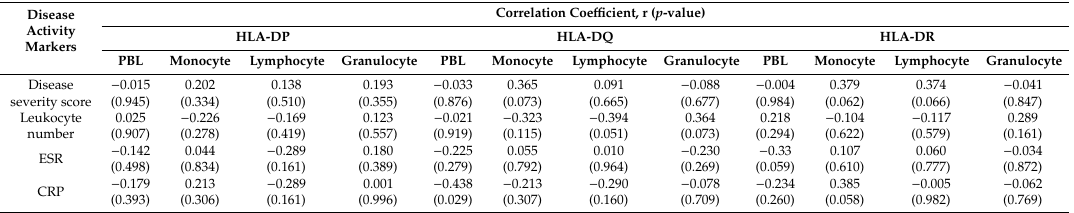
Table 3. Correlations between the frequencies of HLA-DP, DQ, and DR positive cells and disease activity